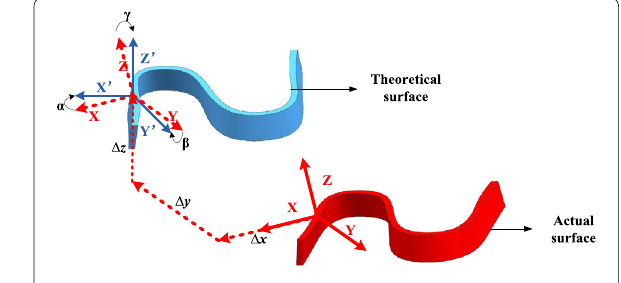
Figure 2 The meaning of the symbols